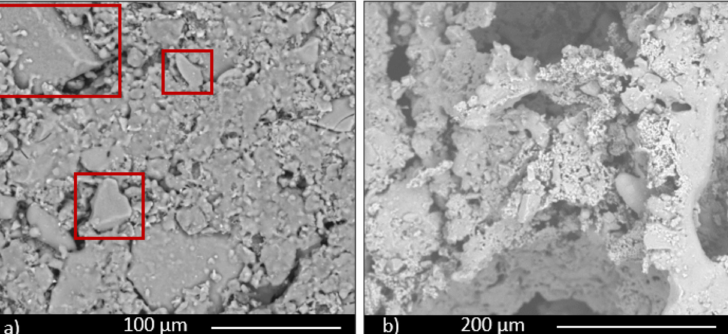
Figure 4. SEM micrographs: ( a ) PR.FG30 and ( b ) scaffold (SS FG30) samples, showing undissolved glass particles.